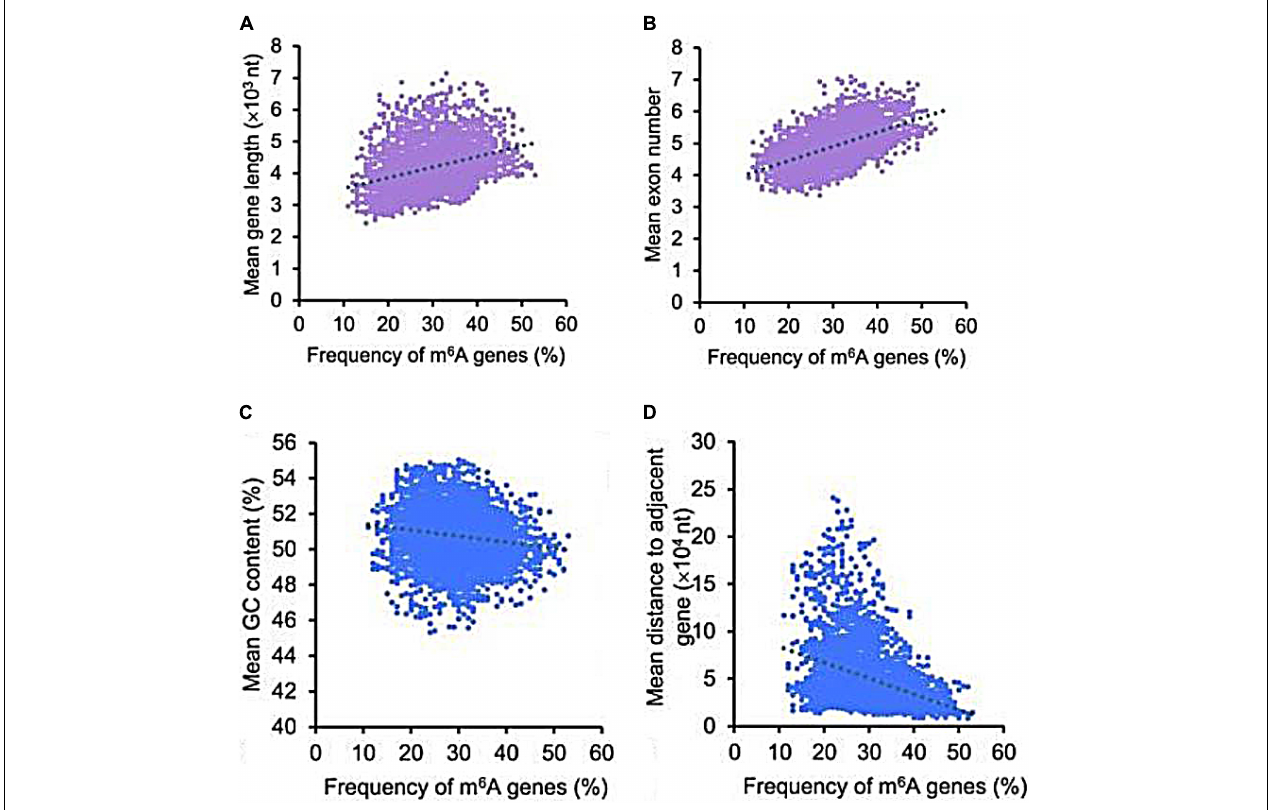
FIGURE 5 | The correlation of m 6 A genes with multiple gene features. The frequency percentage of m 6 A genes was positively correlated with the length (A) and number of exons (B) , but was negatively correlated with GC content (C) and gene distance to the adjacent gene (D) (Miao et al.,